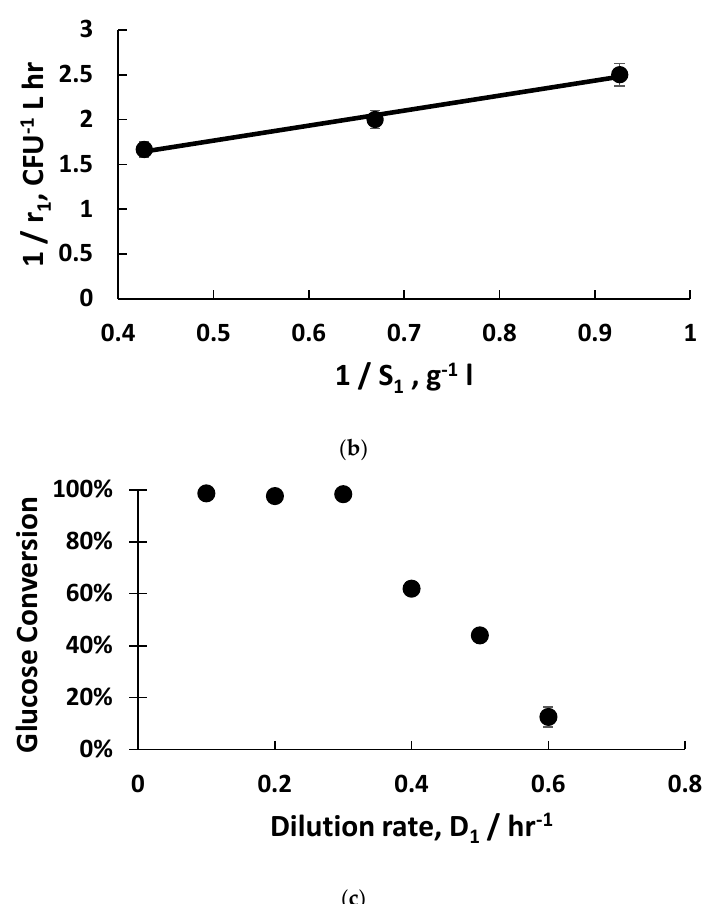
Figure 2. ( a ) Filled circles (●) represent the concentration of host bacterial cells in R1, and filled squares ( ■ ) represent the host bacterial cell productivity in reactor 1 (R1), which are plotted as a function of different dilution rates in R1. ( b ) Host growth rate data fitted with Monod kinetics (3) linearized as a Lineweaver–Burk plot; the slope of the line is K m /µ m , the y-intercept is 1/ µ m , the linear least squares fit yielded values of K m (1.5 g L −1 ) and µ m (1 hr −1 ). ( c ) Glucose conversion as a function of dilution rates in R1. The black filled circles (●) represent the percentage of glucose (compared with the inlet substrate concentration to R1) consumed by E. coli to produce new cells. The residence time in R1 was controlled using the dilution rate D 1 . Error bars represent one standard deviation.